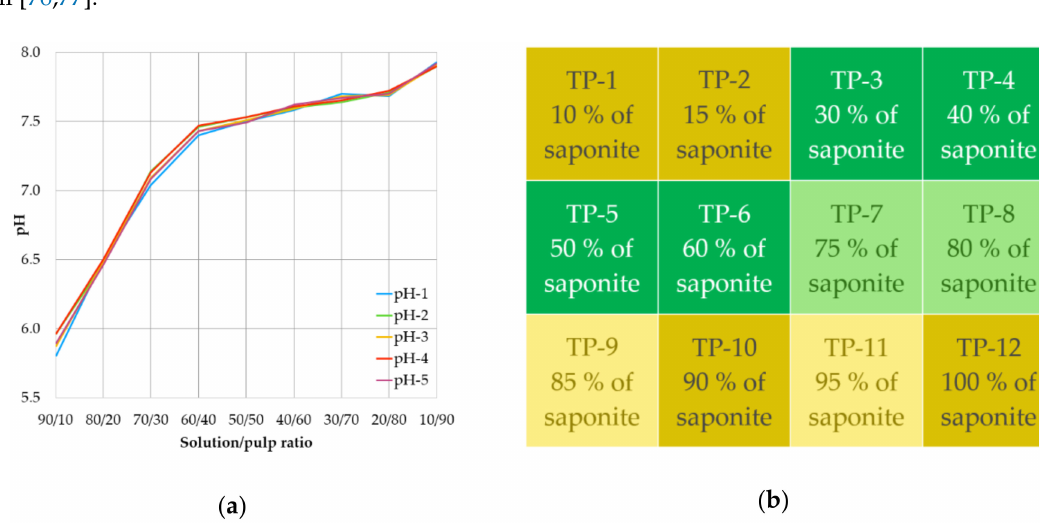
Figure 4. Experimental reclamation of Histosols: ( a ) deacidification curve of pH plotted against the mass ratio of the peat soil KCl-extract to the saponite pulp; ( b ) fertility levels of the created Technosols as a function of the tailings material mass fraction—practically bare surface, projective cover < 0.25 at the sites TP-1, TP-2, TP-10, and TP-12; sporadic vegetation, projective cover 0.25–0.50 at the sites TP-9 and TP-11; sparse vegetation, projective cover 0.50–0.75 at the sites TP-7 and TP-8; and abundant vegetation, projective cover > 0.75 at the sites TP-3, TP-4, TP-5, and